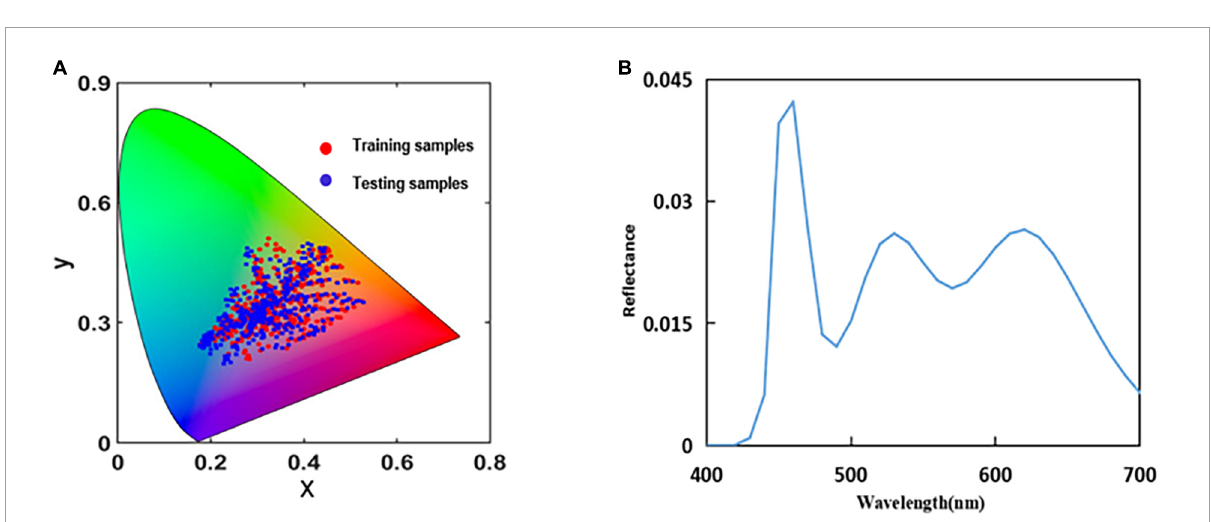
FIGURE6 (A) Distribution of the sample points in the International Commission on Illumination (CIE)1964-XY chromaticity diagram and (B) real spectral power distribution of the light